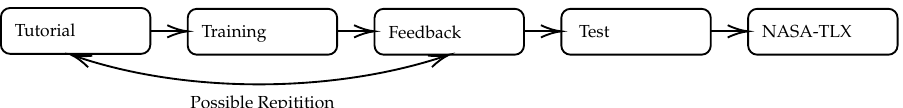
Figure 7. Protocol of a single n -back test sequence. The subject is able to repeat the tutorial and training phases. After training completion, the achieved score is reported to the participant (number of hits and false alarms are shown). Each test run is completed with a NASA-TLX assessment. The test phase takes 2 min to